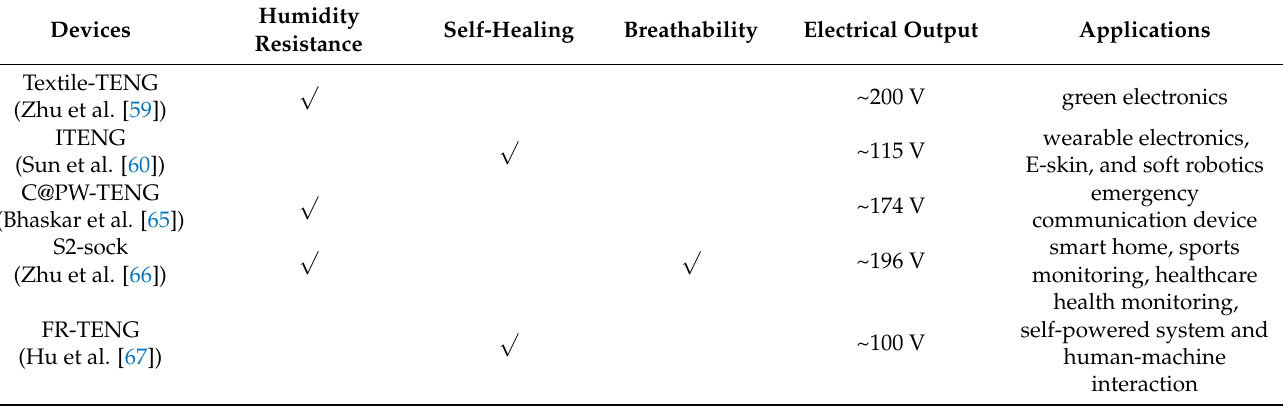
Table 1. Features and application comparison of different TENGs in basic human